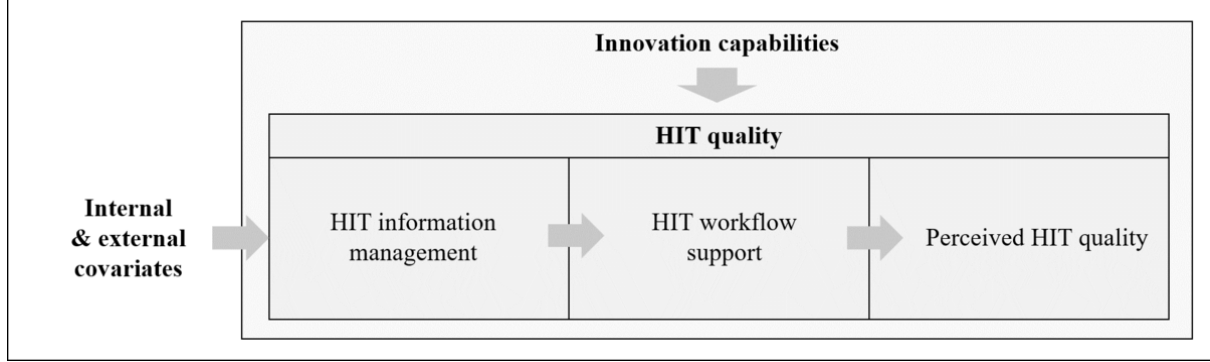
Figure 1. Initial conceptual innovation and quality of health information technology model of the layered relationship between innovation capabilities, health information technology quality, and covariates. HIT: health information